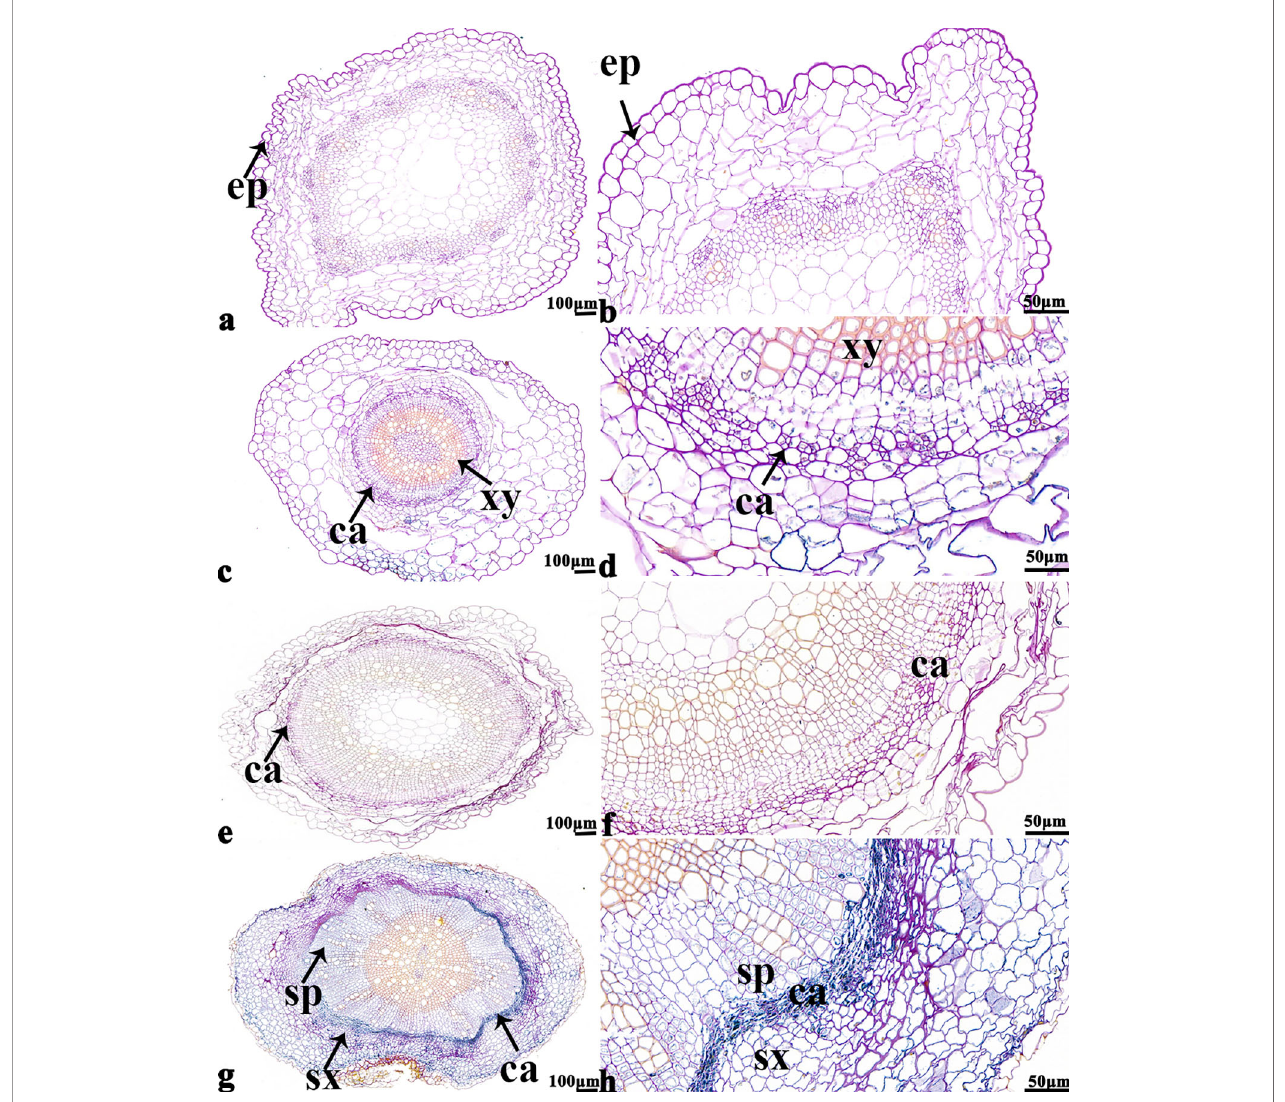
FIGURE 5 | B. napus cultivars 16NTS309 and Tianyou2238 under non-cold (A, B, E, F) and cold stress (C, D, G, H) conditions for 48 h. The deepest root samples with blue formazan precipitate areas in 16NTS309 (A – D) and Tianyou2238 (E – H) were sectioned for morphoanatomical analysis. ep, epidermis; ca, cambium; sp, secondary phloem; sx, secondary xylem. Scale bars = 50 µm and 100